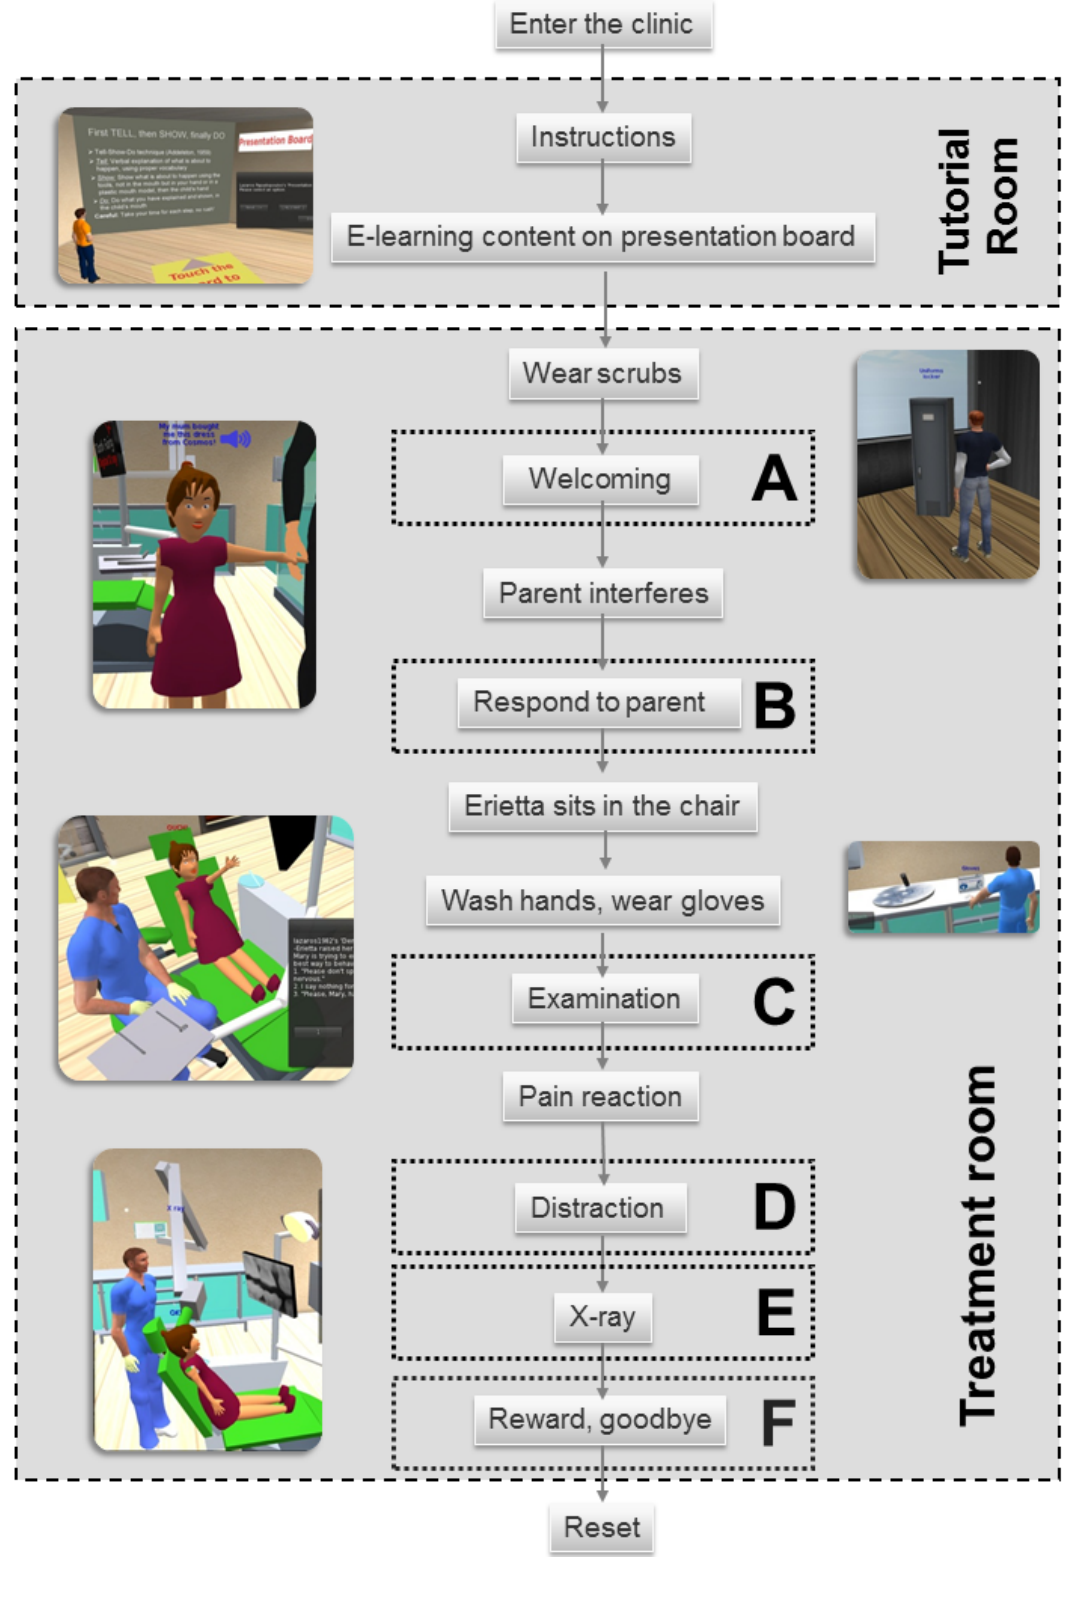
Figure 3. Diagram of the scenario. A: Initial communication (Questions 1-3). B: Talk to Mary (Question 4), C: Tell-Show-Do, word substitution (Questions 5-10). D: Distraction, ask Mary to be quiet (Questions 11-12). E: Tell-Show-Do, diagnosis (Questions 13-14), F: Say goodbye (Question